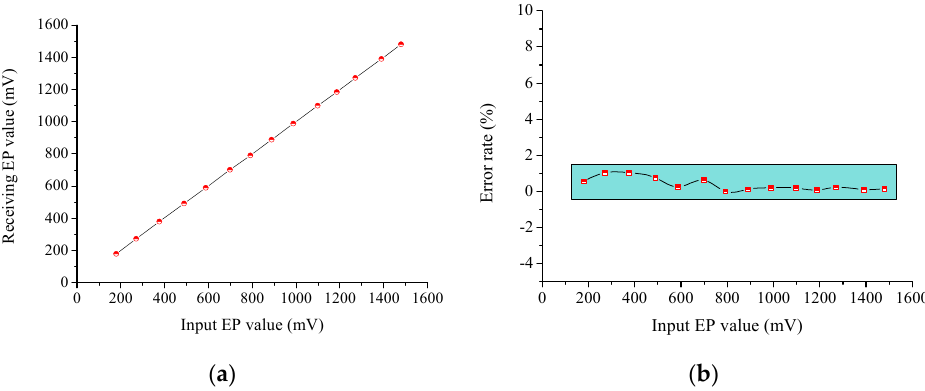
Figure 5. Experimental results of EP measuring emitted by power supply. ( a ) Value comparison of input EP and output EP; ( b ) error rate of comparison results.